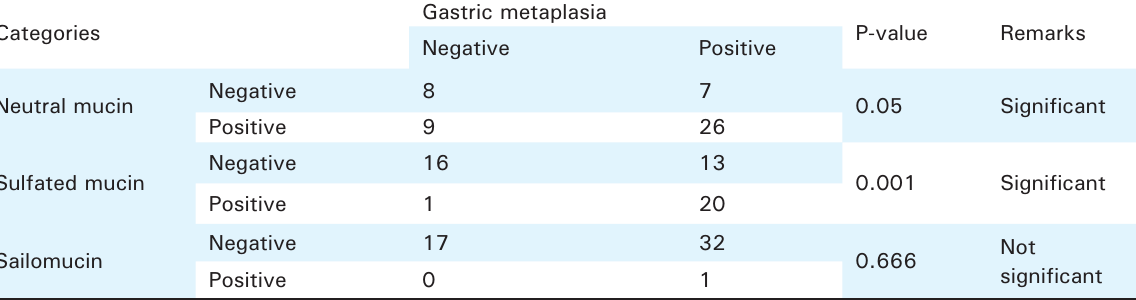
Table 3. Cross tabulations between different types of mucins and gastric metaplasia in gallbladder.